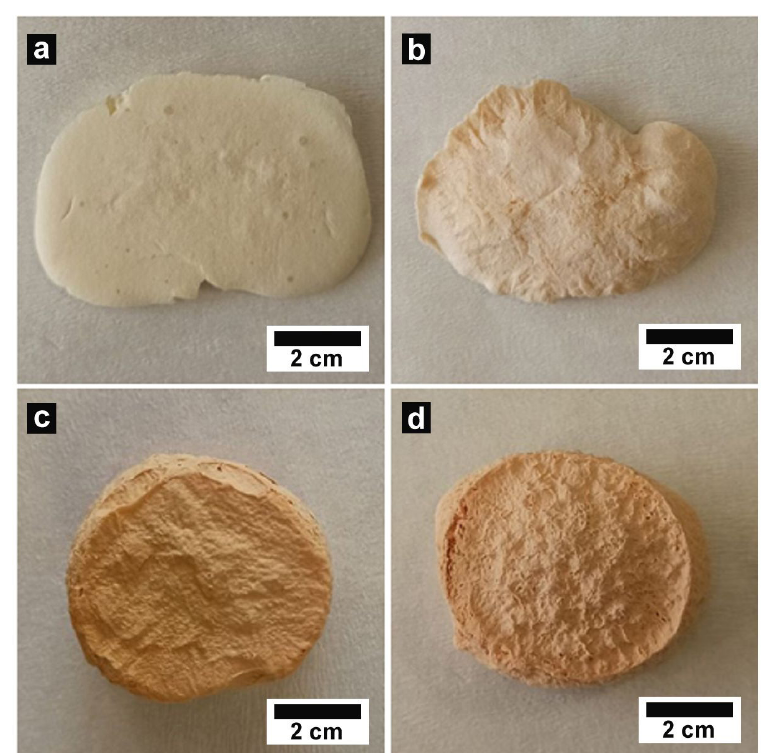
Figure 1. Bone tissue scaffolds formed after freeze drying: (a) BTS-1, (b) BTS-2, (c) BTS-3 and (d) BTS-4.